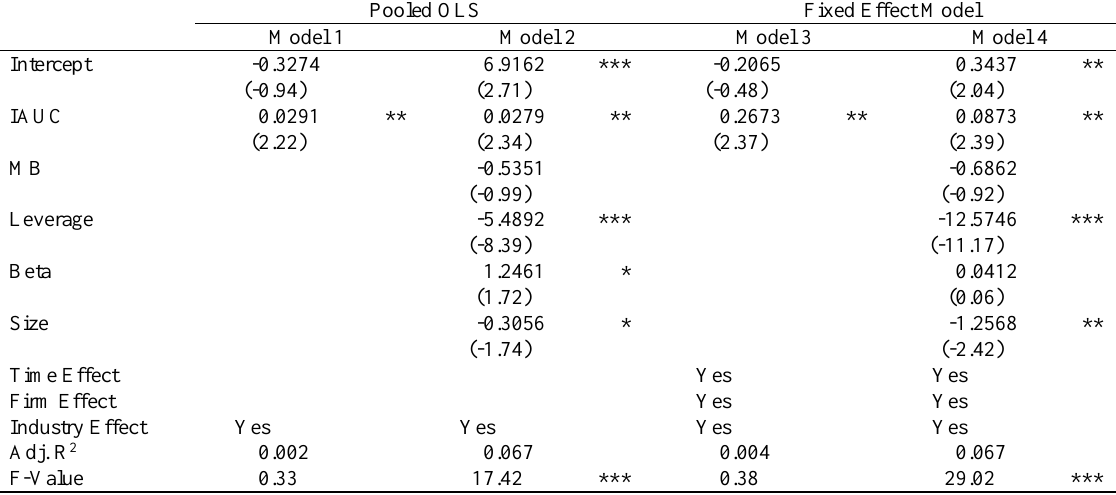
Table 10: Test results on hypothesis 1 for equity cost by using IAUC Pooled